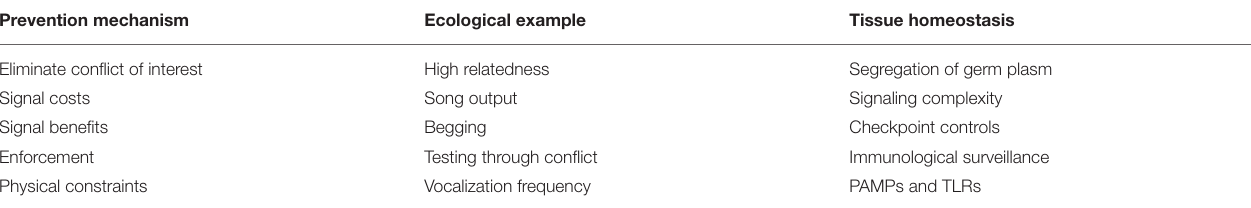
TABLE 2 | Mechansisms of maintaining signal reliability in ecology and in